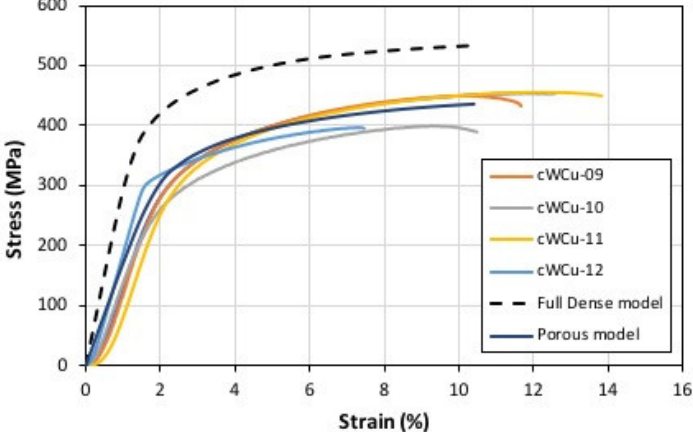
Figure 10. Comparison of the experimental results of cW-Cu specimens with the full dense and porous numerical results.